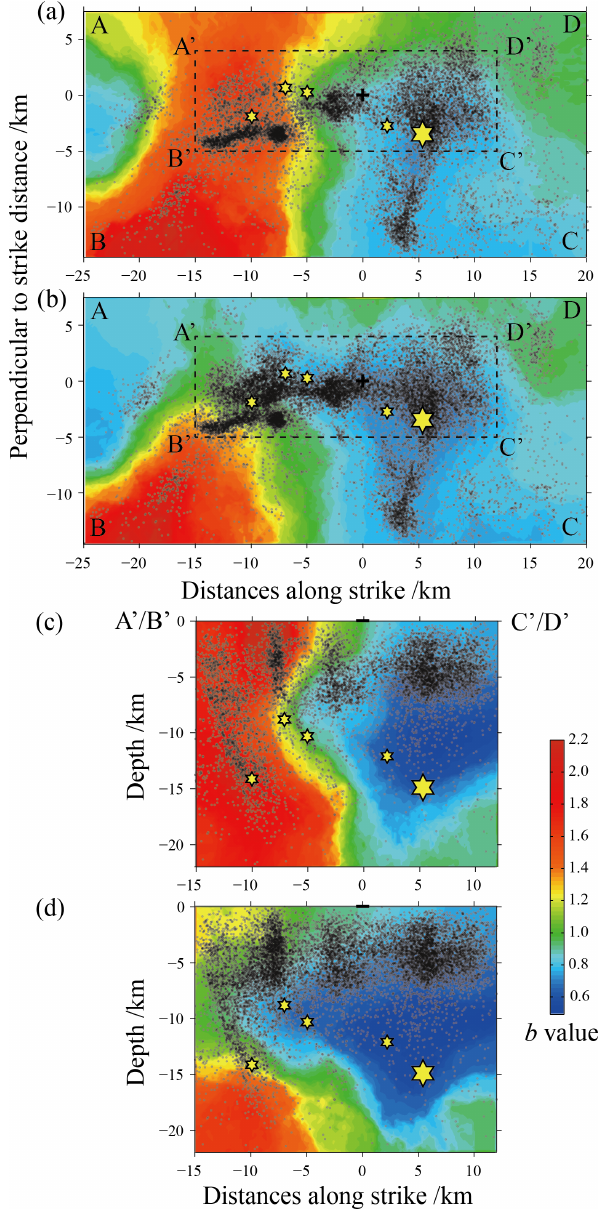
Figure 4. The spatial distribution of the ensemble median b val- ues of the best-100 solutions for N v = 2– N v = 40 in the Changn- ing area. (a) The ensemble median b values before the Changning M S = 6 . 0 earthquake is distributed on the horizontal plane after the rotation; (b) the ensemble median b values obtained by calculation of the whole earthquake including the aftershocks of the Changning M S = 6 . 0 earthquake distributed on the horizontal plane after the rotation; (c) distribution of the ensemble median b values before the occurrence of the Changning M S = 6 . 0 earthquake in the rect- angular frame A (cid:48) B (cid:48) C (cid:48) D (cid:48) on the depth profile; (d) distribution of en- semble median b values obtained by calculation of all earthquakes including aftershocks of the Changning M S = 6 . 0 earthquake in the rectangular frame A (cid:48) B (cid:48) C (cid:48) D (cid:48) on the depth profile. The black dots on each graph mark the seismic events used in the